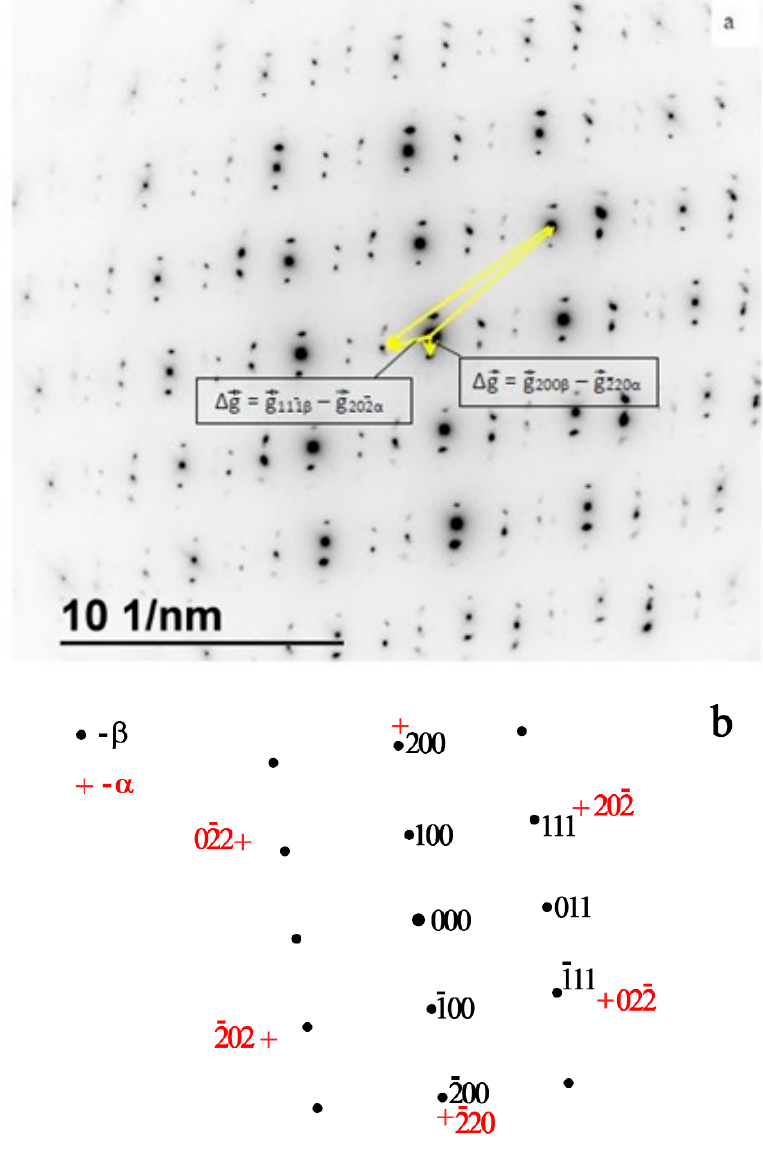
Figure 2. ( a ) SAED pattern of a section of two-phase Cu-Pd36 sample and ( b ) its interpretation: (1) β -phase reflections, (2) α -phase reflections; the other reflections are due to double diffraction. The highlighted vectors correspond to the interference bands in Sections 1 and 2.